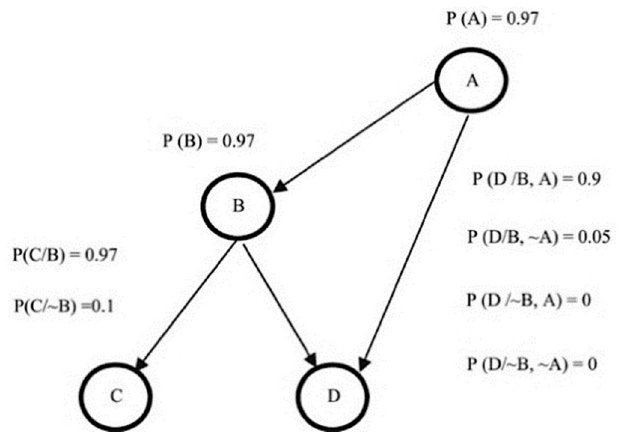
Figure 12. Bayesian network (BN) graph representation [130].